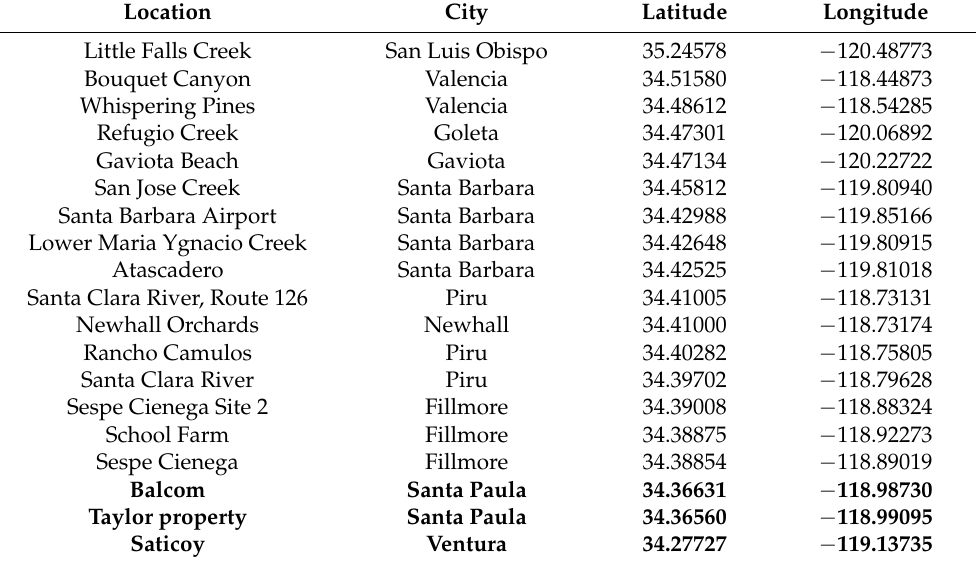
Table 1. Locations and coordinates (WGS 1984) of Arundo donax stands sampled for Rhizaspidiotus donacis throughout central and southern California. Rhizaspidiotus donacis was found only at locations with bold